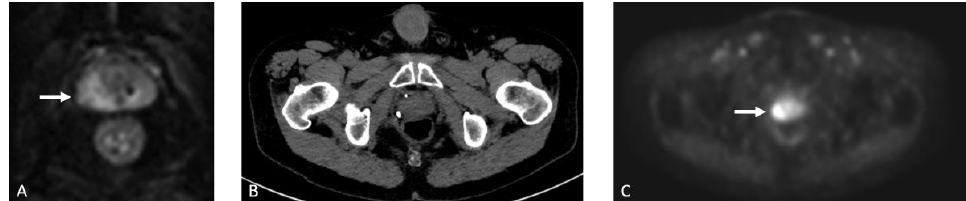
Figure 5. Eighty-four-year-old male with elevated PSA levels. PET image shows increased uptake within the right lateral peripheral zone concerning for recurrence. Corresponding CT shows no abnormality in the area of pathology. Magnetic resonance imaging (MRI) Diffusion-Weighted-Imaging (DWI), ( A ) sequence through the prostate shows increased DWI signal in the right mid-gland (arrow), PiRads 5. NECT ( B ) shows no discernable abnormality in the area of interest; however, corresponding Axumin PET ( C ) shows intense Axumin uptake (arrow).